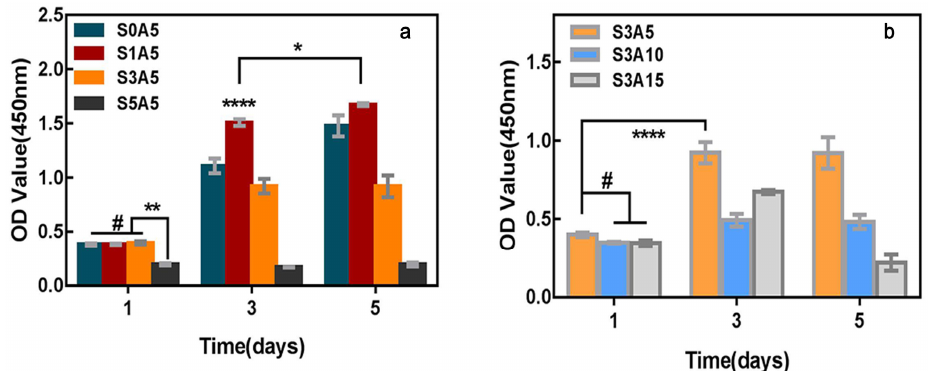
Figure 9. MC3T3-E1 cell proliferation on PLA/GO/Sal-B/ASA dual drug-loaded biomimetic com- Figure 9. MC3T3 ‐ E1 cell proliferation on PLA/GO/Sal ‐ B/ASA dual drug ‐ loaded biomimetic compo ‐ site scaffolds with different Sal ‐ B content ( a ) and different ASA content ( b ) after 1, 3 and 5 days of posite scaffolds with different Sal-B content ( a ) and different ASA content ( b ) after 1, 3 and 5 days of culture ( n = 3, mean ± SD, # p > 0.05, * p < 0.05, ** p < 0.01 and **** p < 0.0001). culture ( n = 3, mean ± SD, # p > 0.05, * p < 0.05, ** p < 0.01 and **** p <